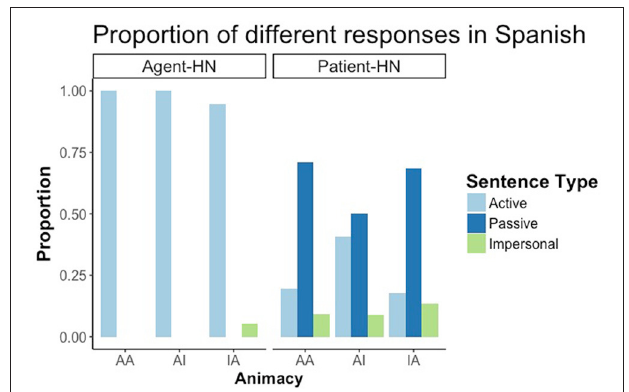
FIGURE 4 | Proportion of active, passive and impersonal responses in RCs with the Agent as HN and the Patient as HN in Spanish.